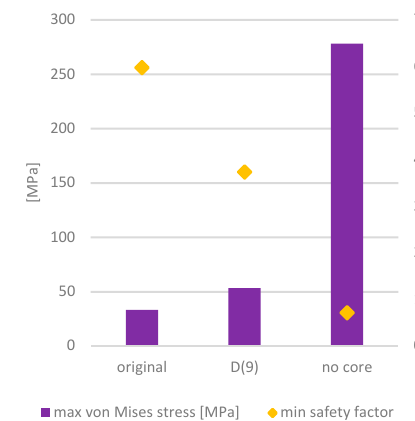
Figure 11. Rudder upward ( l ) load case analysis results. Optimized bulb interior definitive shape results as in Figure 12a,b and isolated op- timized core geometry is observable in Figure 12c,d. It is also visible the evacuation site for internal powder removal. It is located in a low stress region as well as a hidden and sufficiently covered position in terms of isolation with respect to eventual water penetration since it would be surmounted by rudder vertical encastre extremity.